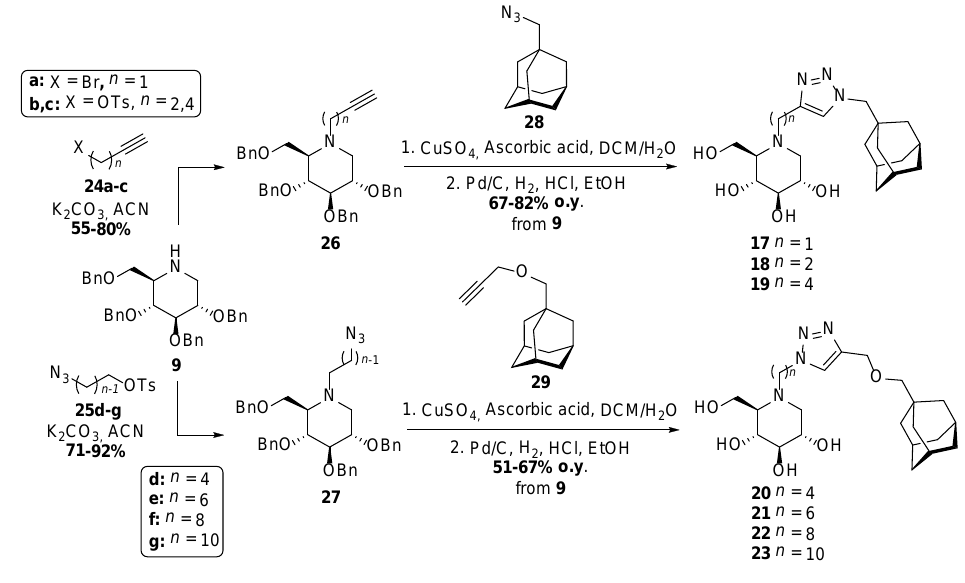
Scheme 3. Synthesis of DNJ-adamantane conjugates [98].